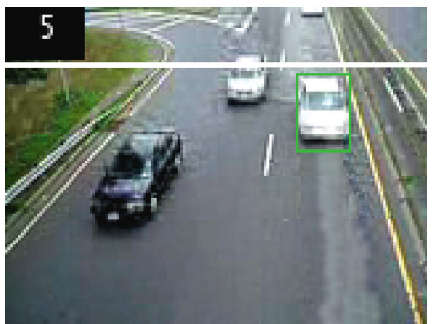
Figure 9: Detection result of frame